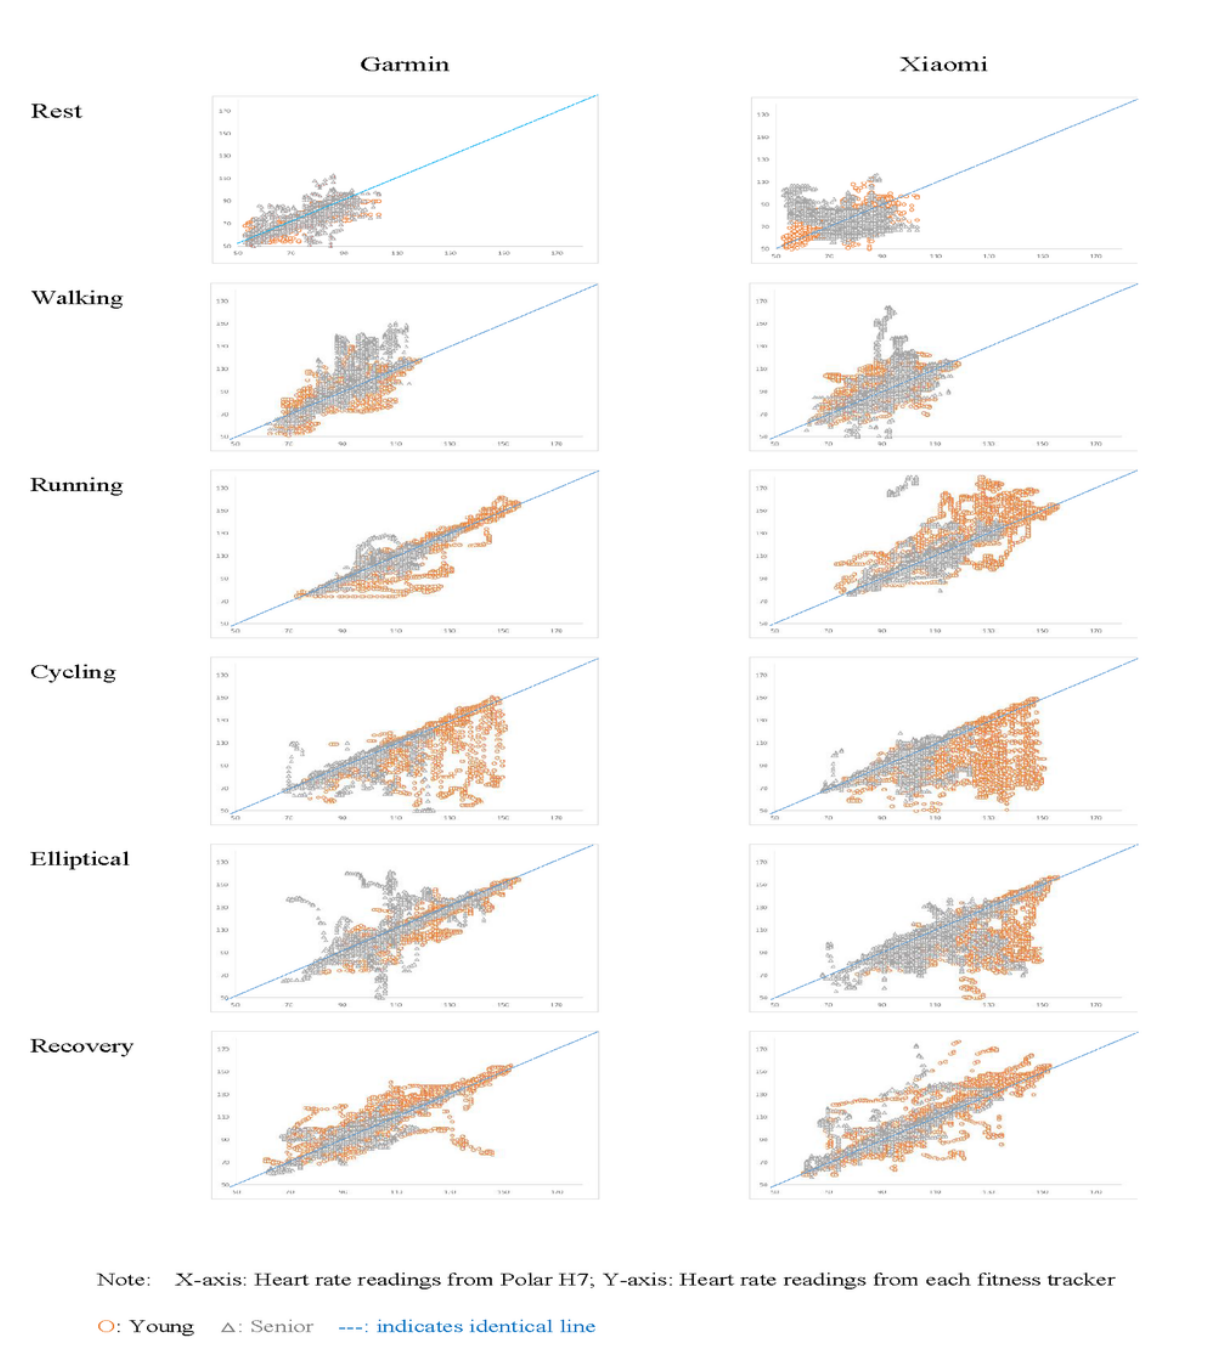
Figure 2. Scatter diagrams of the different phases of activities for different devices and